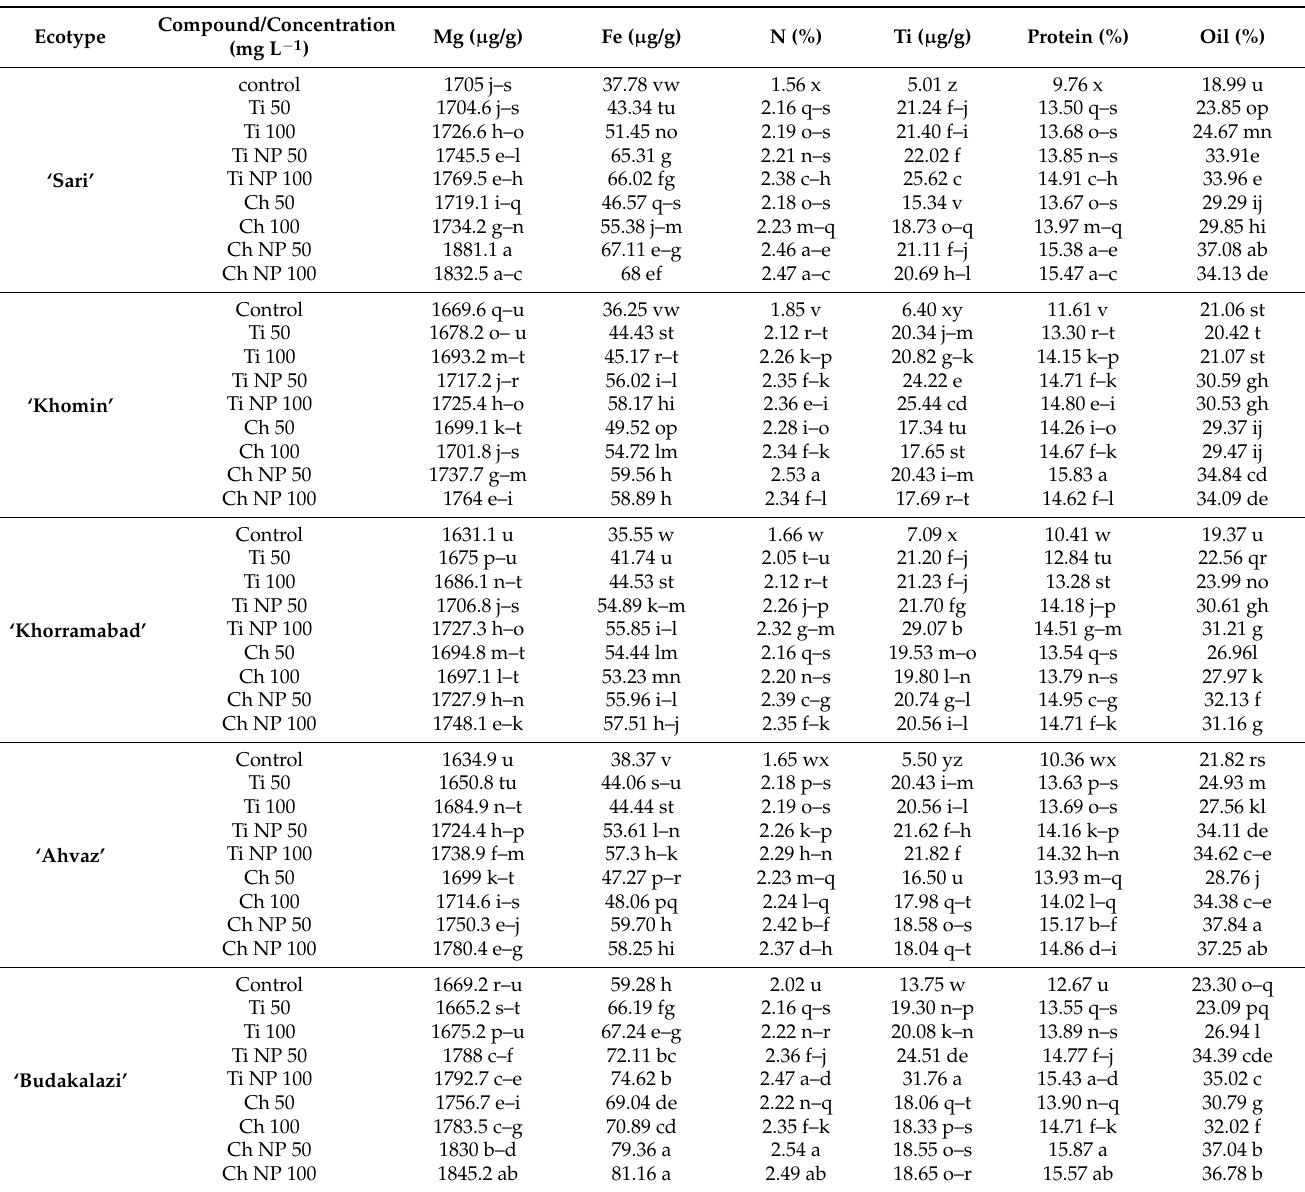
Table 9. Effects of chitosan and titanium dioxide (denoted as Ch and Ti, respectively) treatments [bulk, nanoparticle (NP)] applied at three concentrations (0, 50, and 100 mg L − 1 ) on seed mineral, protein, and oil content of five milk thistle ecotypes. Three plants per treatment were assessed. Different letters within a column indicate statistically significant differences ( p < 0.05). For parameters (N and protein contents) showing significant interaction effects among all three factors involved (ecotype × treatment × year), the comparison of year means is provided in Table